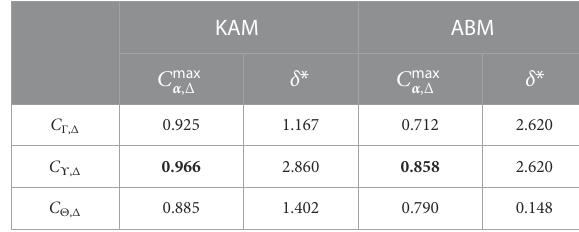
TABLE 5 Maximum values of correlations and their